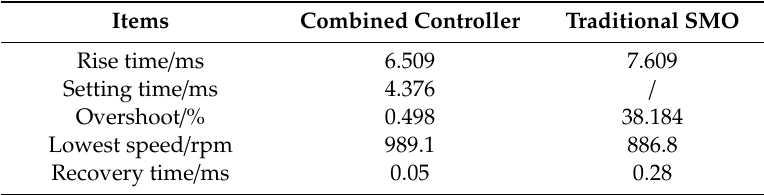
Figure 6. The speed response results without compensation and with compensation in high-speed condition (the blue line indicating the speed response results with compensation, and the red line indicating the speed response results without compensation). Table 3. Simulation comparison performance ( N r = 1000 r /